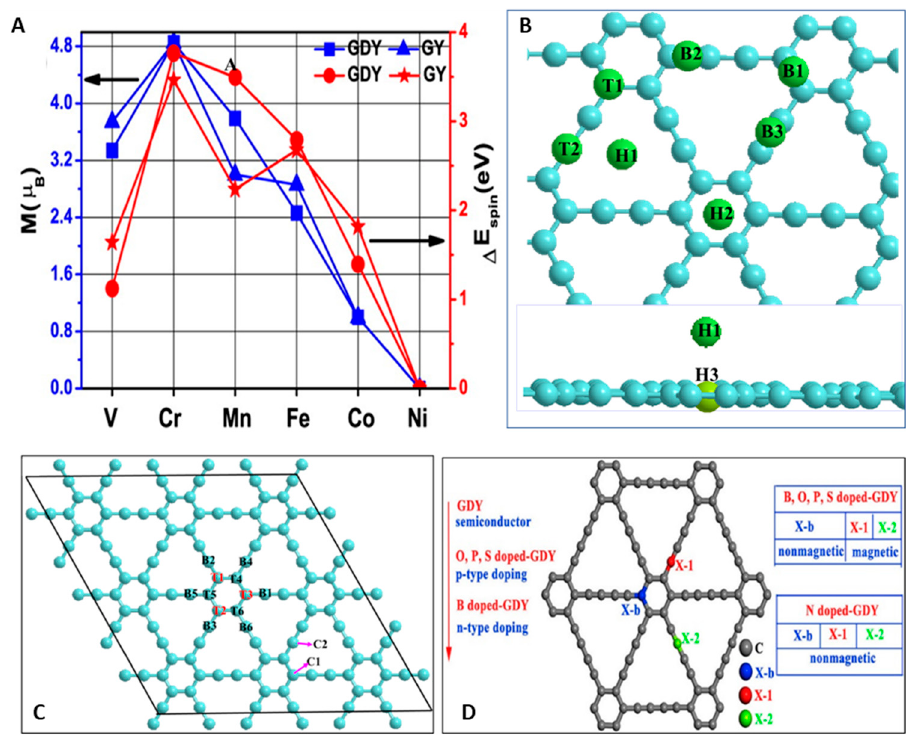
Figure 19. The magnetic moment (µB) and Δ E spin ( A ). Reproduced with permission [164] Copyright 2012, American Chemical Society. The adsorption sites (green spheres) of transition metal atoms on a γ -graphyne film seen from the top (upper image); the in-plane case of H3 and its relation to the H1 site seen from a side (bottom image), blue points represent carbons ( B ). Redrawn [165]. Possible sites on GY for hydrogenation ( C ). Redrawn based on [171]. Possible site for doping by X = B, N, O, P, and S atoms ( D ). Reproduced with permission [172]. Copyright 2020, Elsevier.